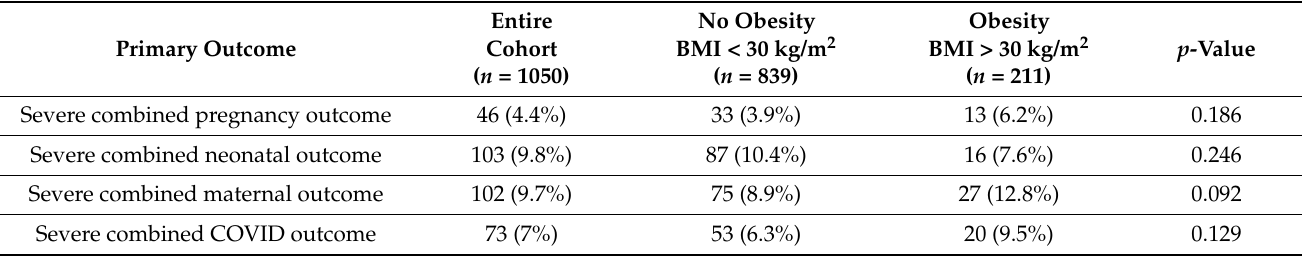
Table 3. Severe Combined Primary Outcome for total ( n = 1050) and the subgroups of women without obesity and with obesity.